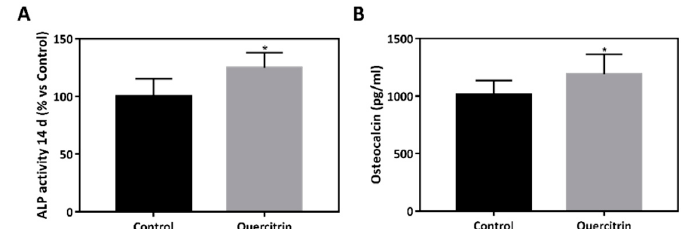
Figure 5. Bioactivity of the porous implants. A) Alkaline phosphatase activity of MC3T3-E1 cells seeded onto the 3D implants after 14 days of culture ( n = 12). B) Osteocalcin levels released to culture media of MC3T3-E1 cells cultured onto the 3D implants at 14 days of culture ( n = 12). Values represent mean (SD). Results were statistically compared by Student’s t -test: * p < 0.05 vs.